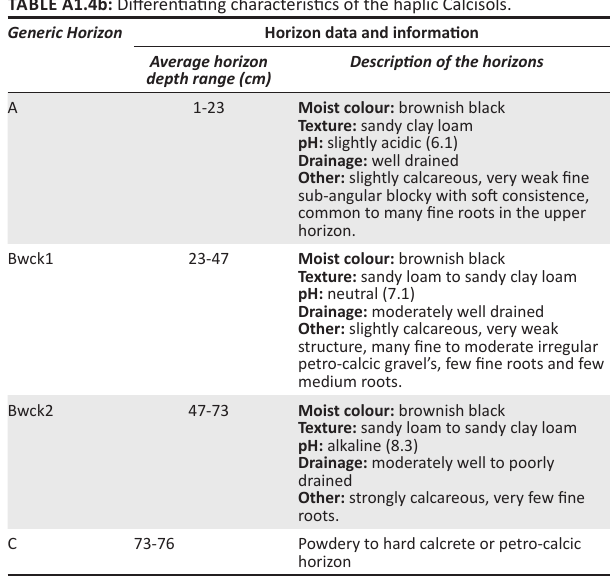
TABLE A1.4b: Differentiating characteristics of the haplic Calcisols.